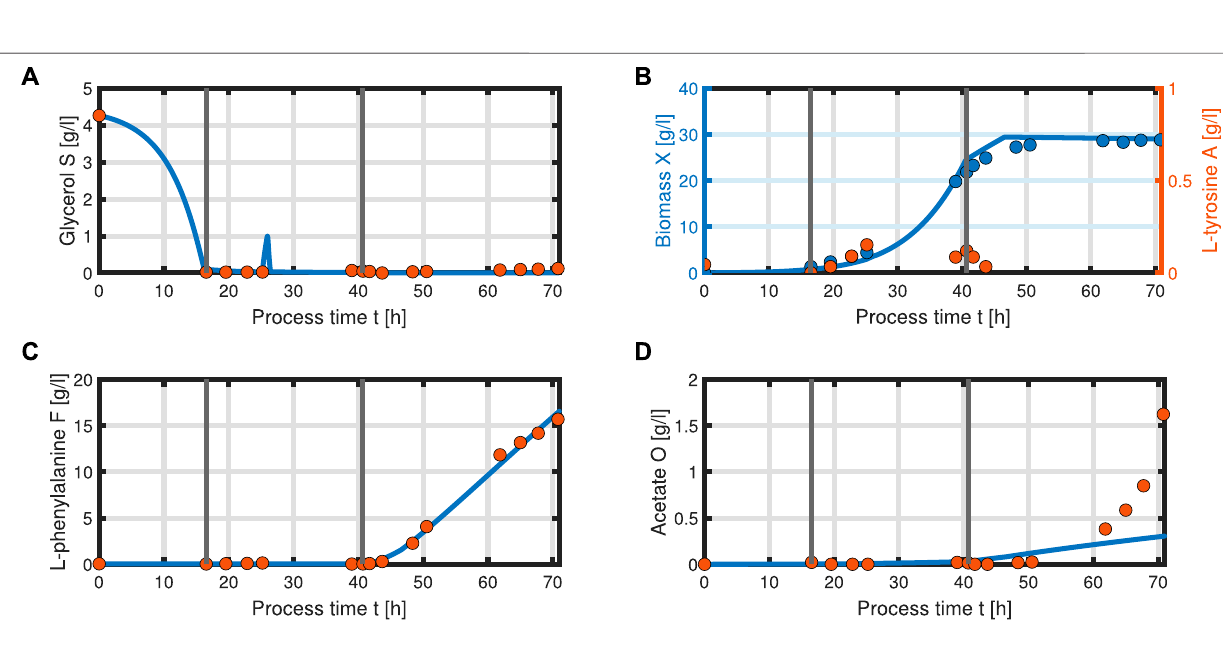
Frontiers in Molecular Biosciences |